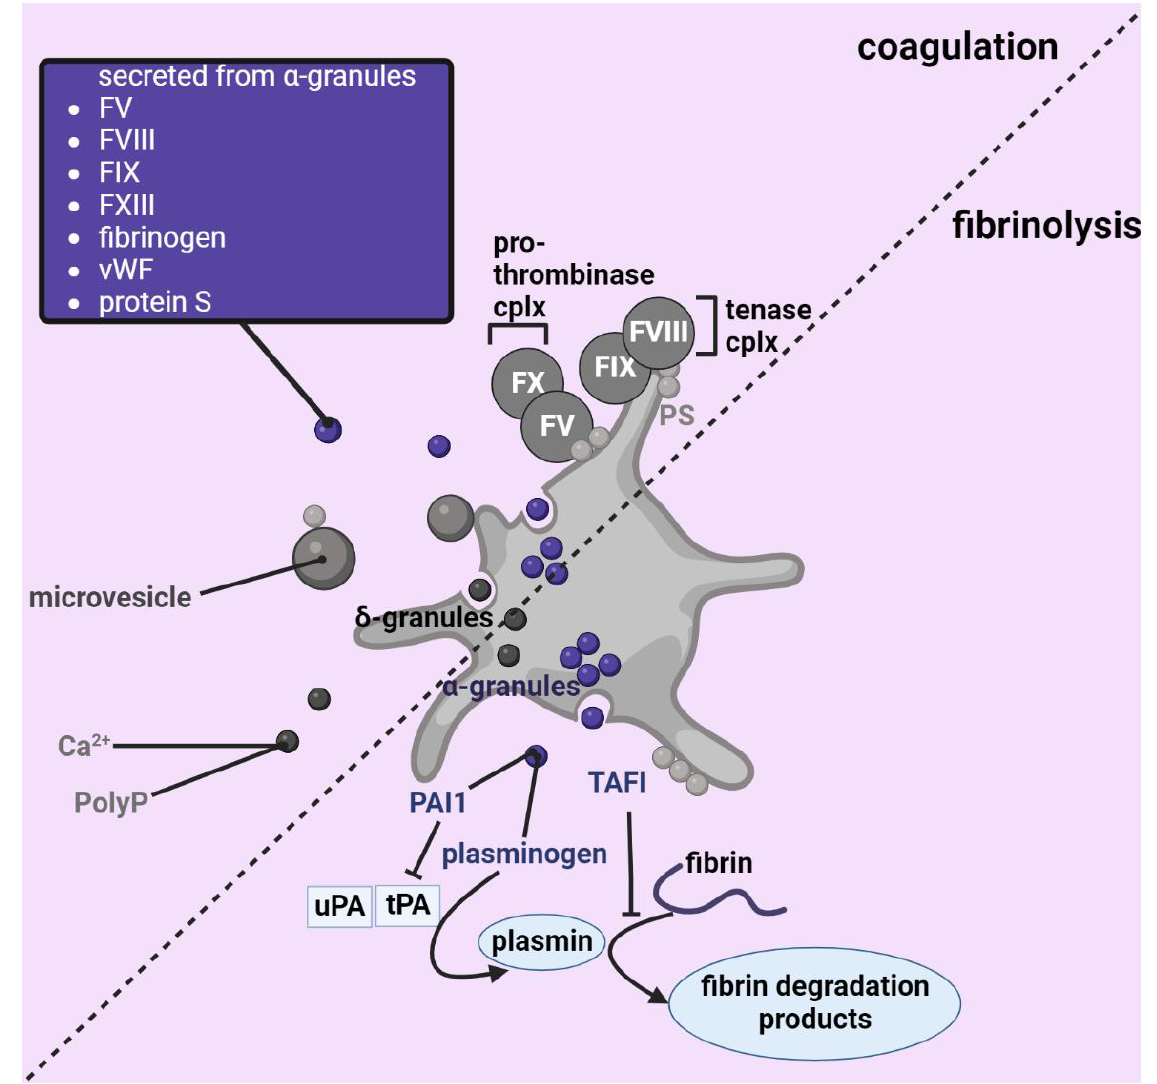
Figure 2. The role of platelets in coagulation and fibrinolysis. Platelets are involved in both coagu- lation and fibrinolysis. Upon activation, they can secrete microvesicles, coagulation and fibrinolysis factors from their α -granules, and Ca 2+ and polyphosphates (polyp) from their dense granules. In addition, they expose phosphatidylserine on their membrane to support both coagulation and fibrinolysis. FV: coagulation factor V, FVIII: coagulation factor VIII, FIX: coagulation factor IX, FXIII: coagulation factor XIII, vWF: von Willebrand factor, FX: coagulation factor X, PAI1: plasminogen